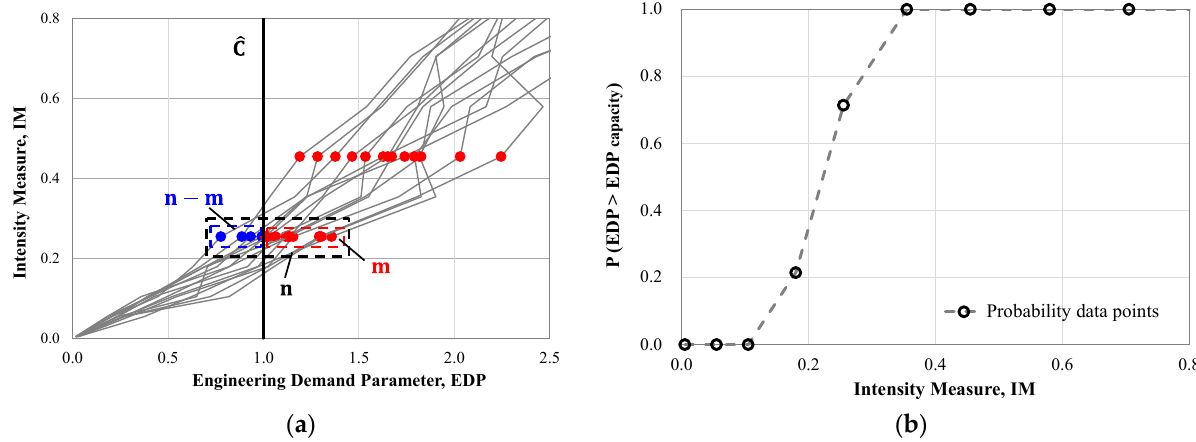
Figure 1. ( a ) Set of IDA curves and stripes of EDP at discrete values of IM, ( b ) Fragility curve based on empirical cumulative distribution function (CDF).